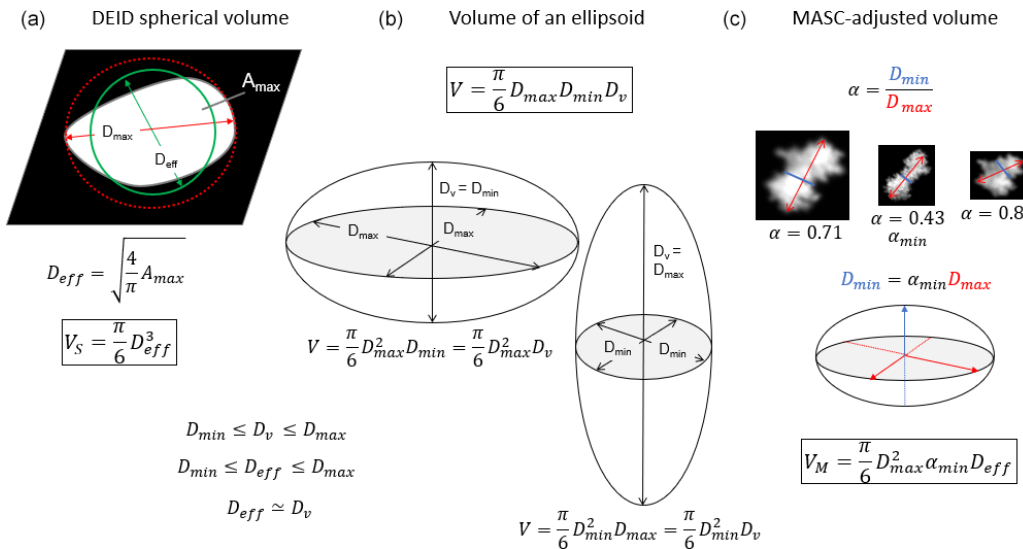
Figure 4. Illustration of the diameter and volume calculations by the DEID (a) , maximum and minimum theoretical bounds of volume calculations of spheroids (b) , and the corresponding volume adjustment using MASC-derived aspect ratio measurements (c) .